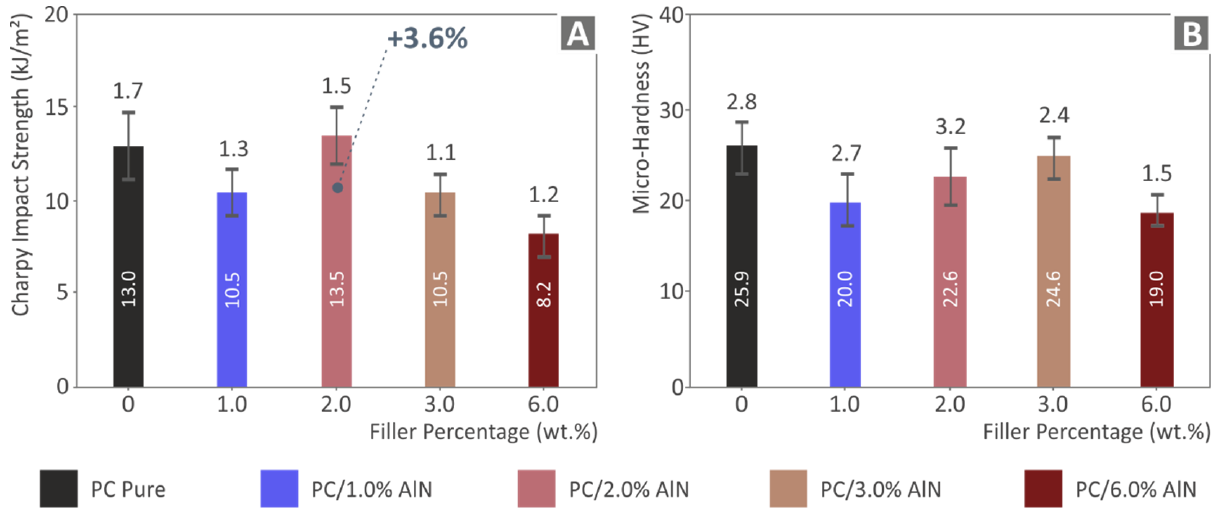
Figure 12. ( A ) Impact strength results (average value and deviation) ( B ) Vickers microhardness results (average value and deviation) of the five tested specimens.